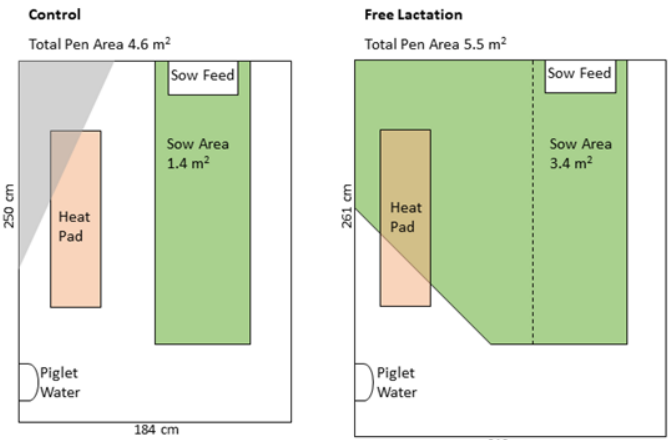
Figure 1. The Control and Free pen design. The area available to the sows in Control pens was 1.4 m 2 and was the same in Free pens while the crate was closed, and 3.4 m 2 when the crate was open. Water was available to sows ad libitum from a drinker located at the feed trough.